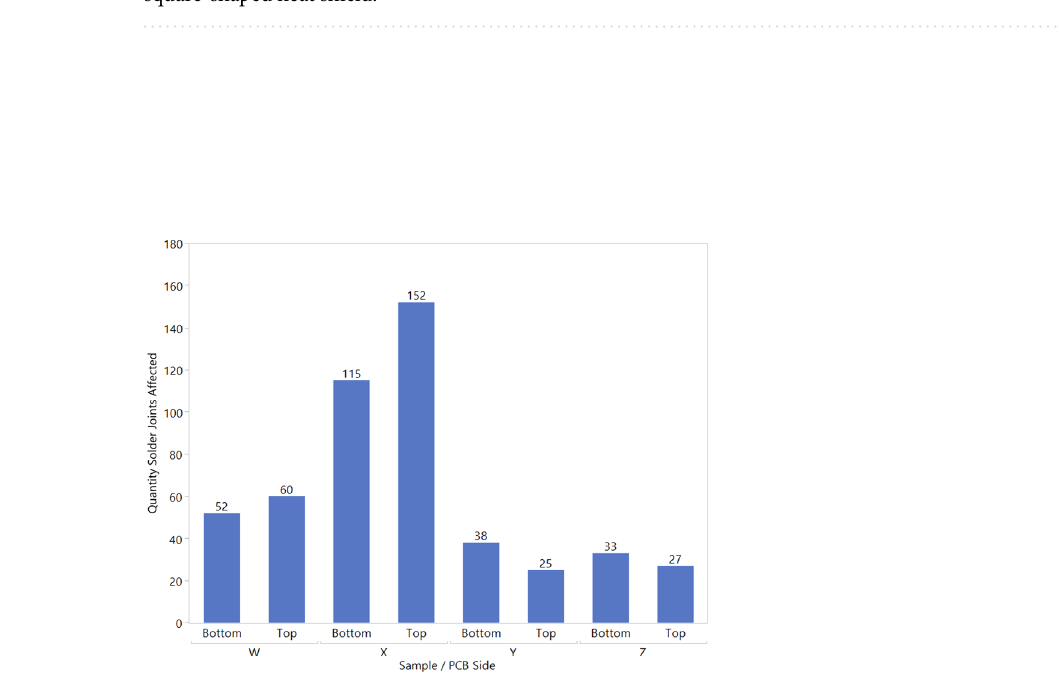
Figure 4. Bar chart on quantity solder joints affected with dye penetration across all